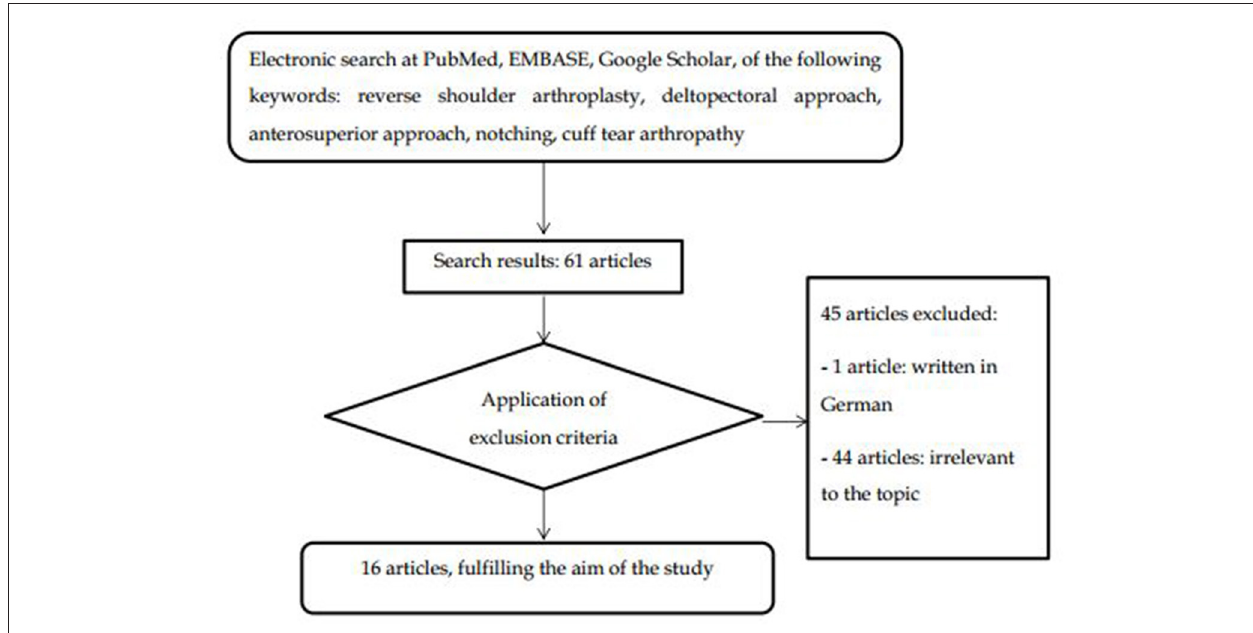
FIGURE 1 | Flow chart of the search strategy.